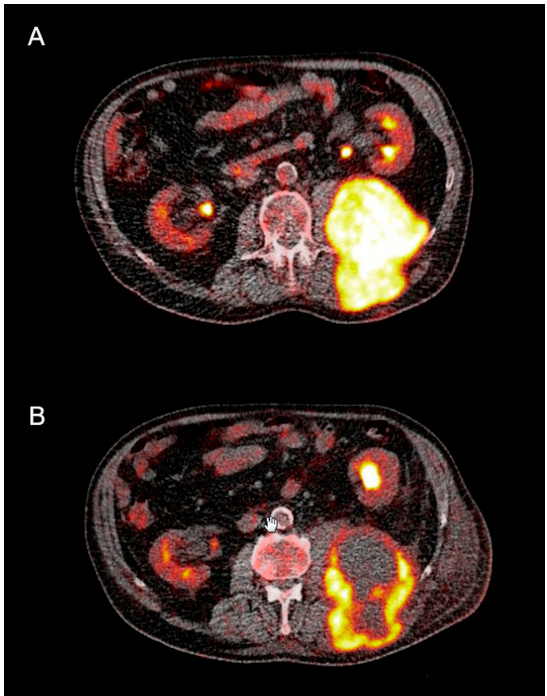
Figure 2. Transaxial fludeoxyglucose F-18 positron emission tomography/computed tomography ( 18 F-FDG PET/CT) of an 80-year old male patient with retroperitoneal sarcoma infiltrating the back muscles before ( A ) and after pazopanib therapy ( B ). Clear metabolic remission of the initially intense metabolic lesion with areas of central necrosis in response to pazopanib.